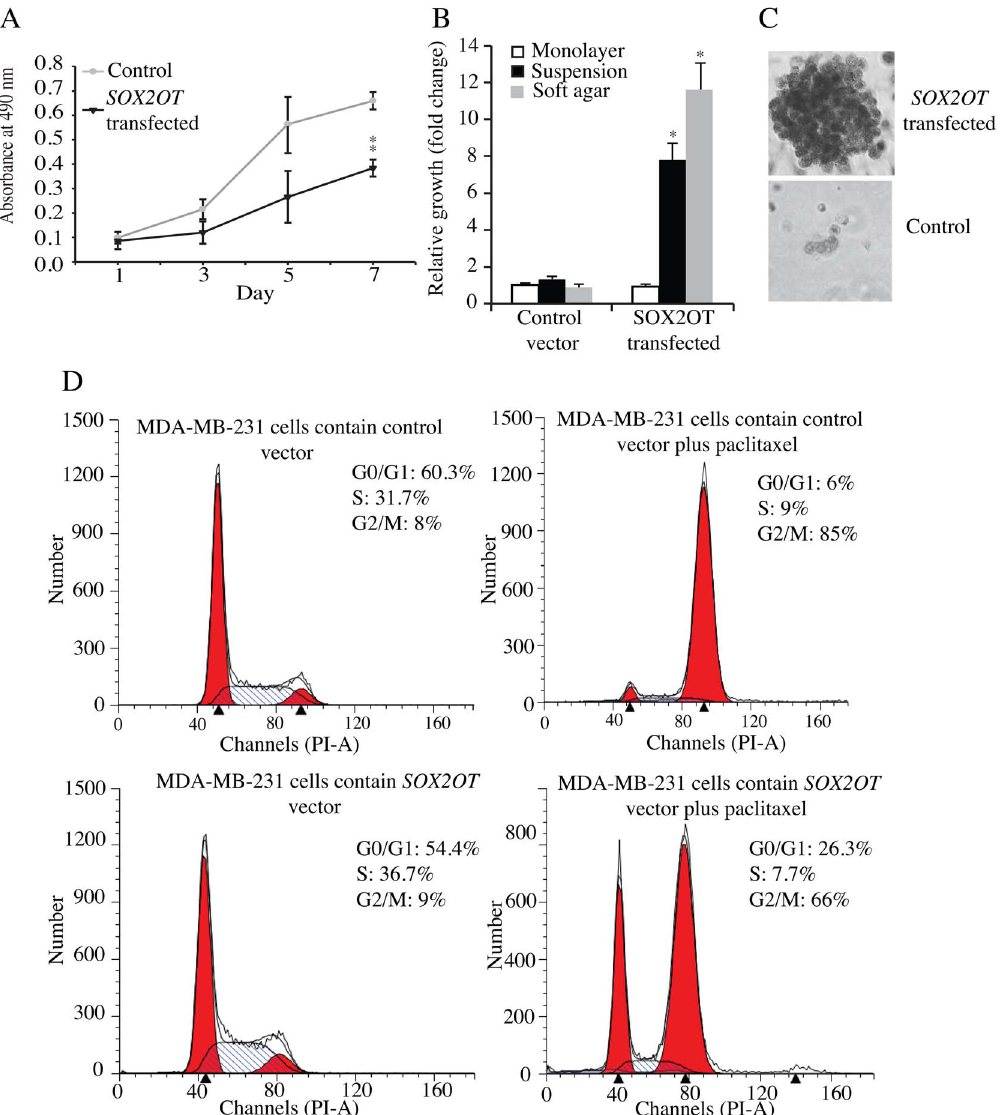
Figure 5. Effect of ectopic expression of SOX2OT on cell growth. A) The proliferation rates of cells transfected with control vector and plasmid containing the SOX2OT gene were measured after 1, 3, 5 and 7 days of culture. B) Proliferation rates of cells transfected with control vector or plasmid containing the SOX2OT gene, in monolayer and suspension culture, as well as in soft agar. * and ** represent p values of , 0.05 and 0.01 respectively. C) Image of MDA-MB-231 cells grown in soft agar for two weeks. The top panel represents the colony form in cells with ectopic expression of SOX2OT . The bottom panel represents cells containing the control vector. D) Effect of ectopic expression of SOX2OT on cell cycle distribution. The cells were treated with and without paclitaxel for 24 h and stained with PI. Following FACS analysis, DNA histograms were analyzed using ModFit LT. The data are representative examples for duplicate tests.